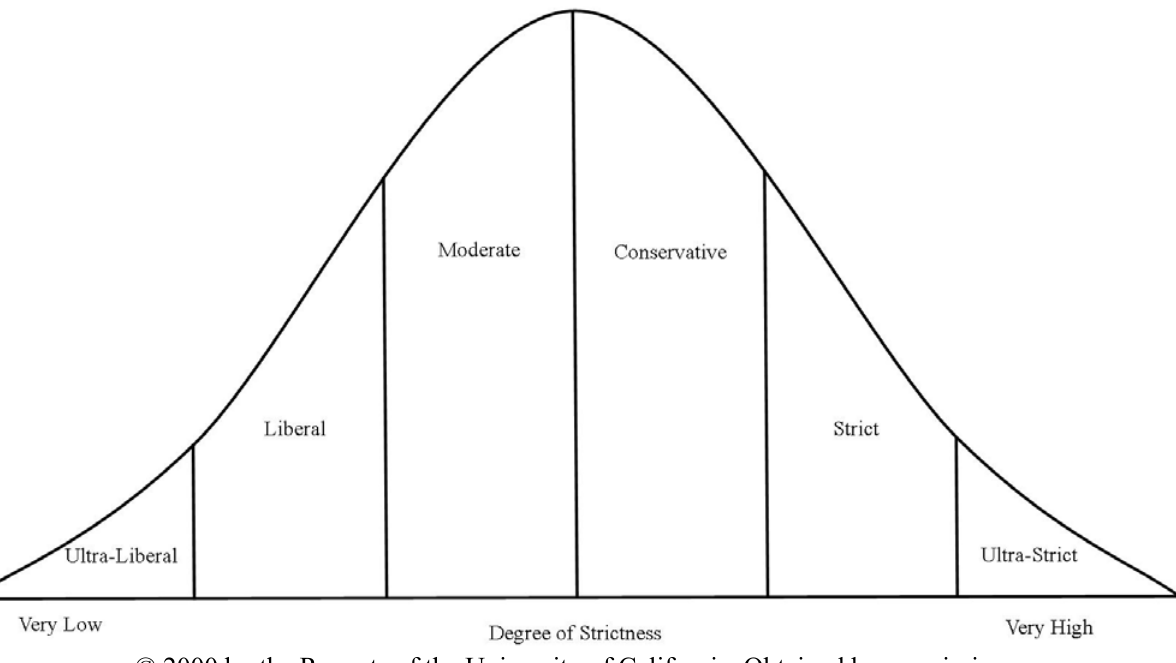
Figure 1. Religious Niches. Source: Stark and Finke